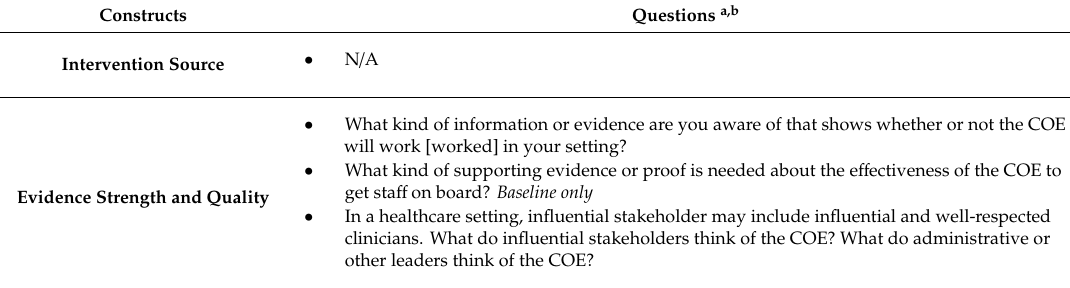
Table A1. Survey Questions by CFIR